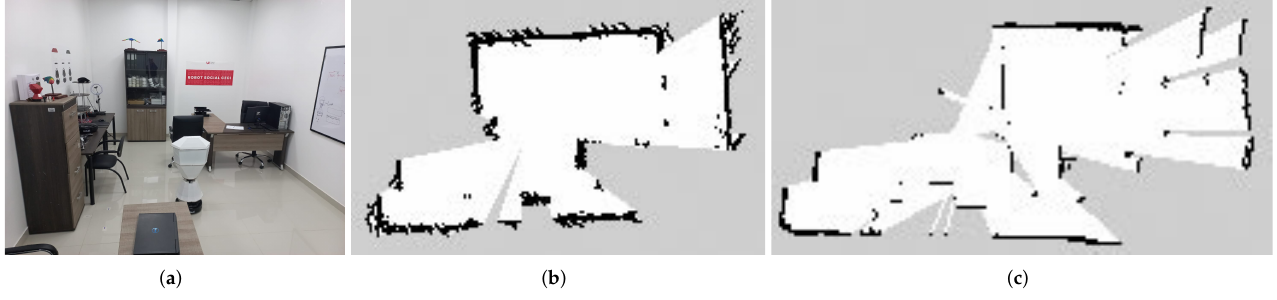
Figure 11. ( a ) Office. ( b ) Mapping of office with Hector SLAM. ( c ) Mapping of office with